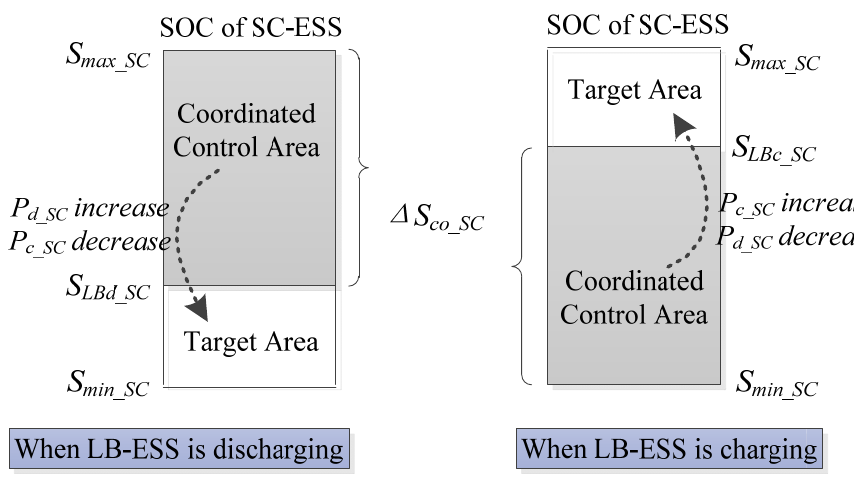
Figure 2. Flow chart of the coordinated control strategy for HESS.